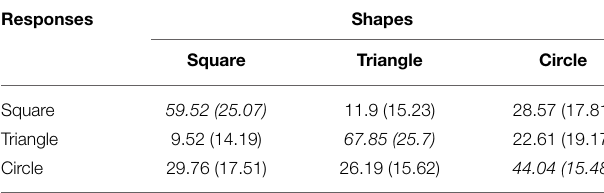
TABLE 5 | Response matrix for Experiment 3.